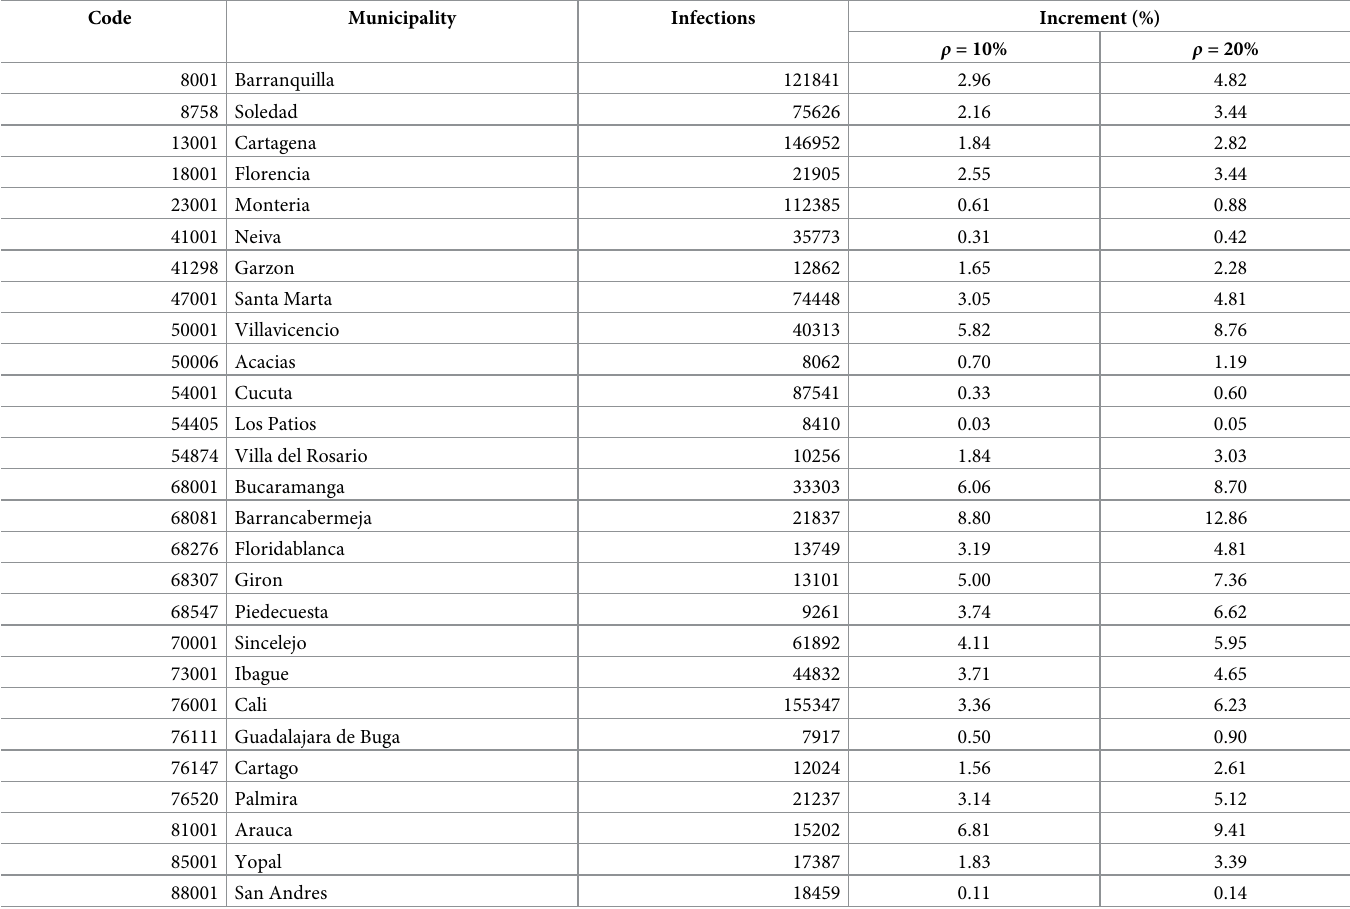
Table 8. Percentage of increment of ZIKV infections according to the proportion of unprotected sexual interactions.